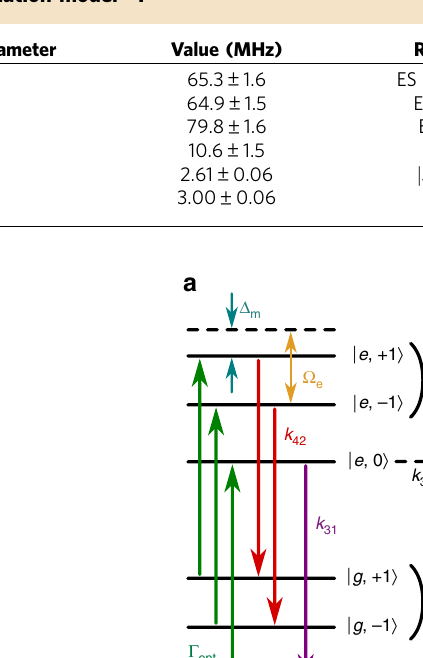
Table 1 | Relaxation rates used in our seven-level master equation model 47 .